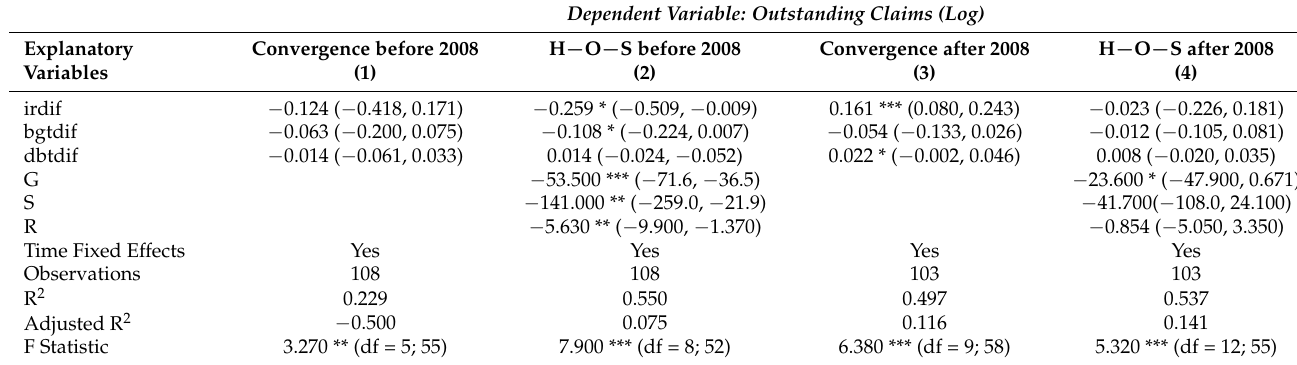
Table 3. Regression Results.